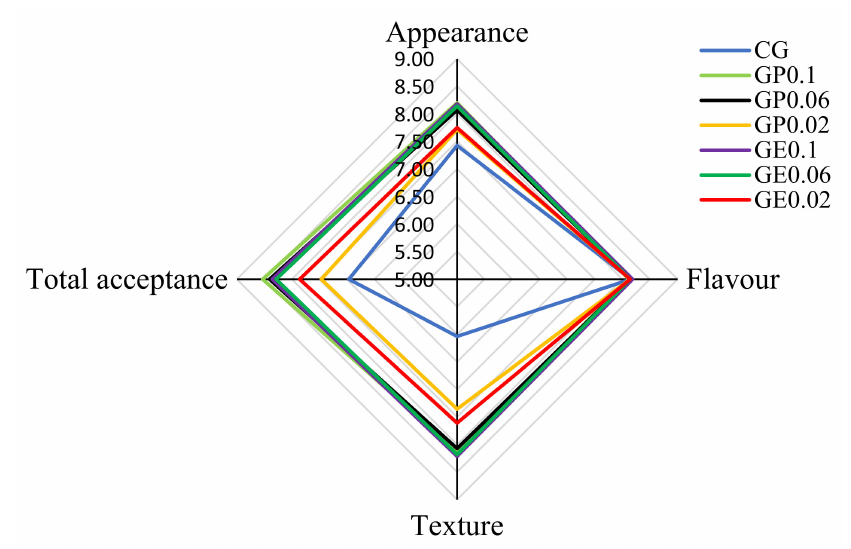
Figure 5. Sensory properties of yogurt